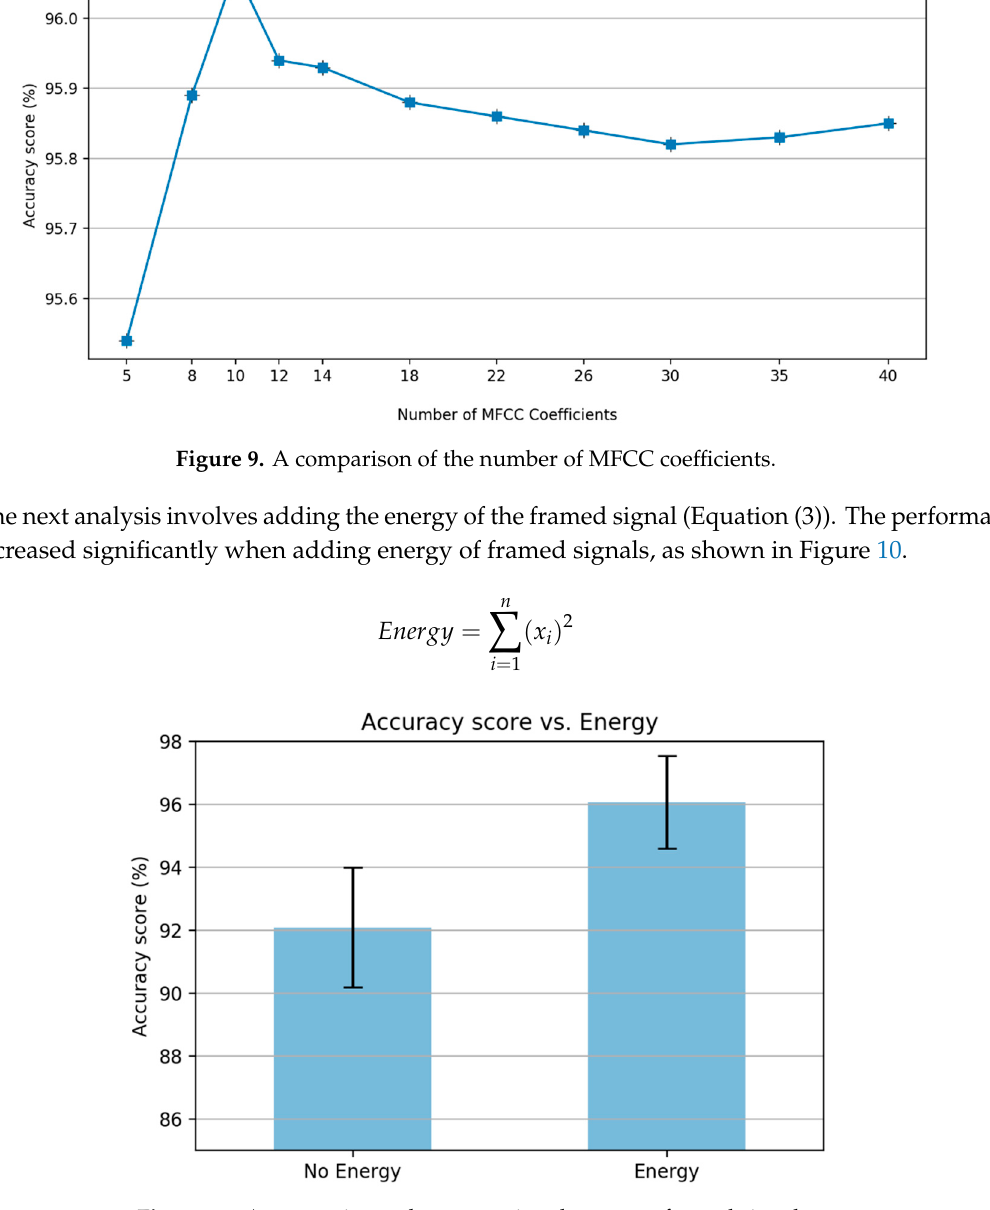
Figure 11. Accuracy score based on MFCC with deltas coefficient.